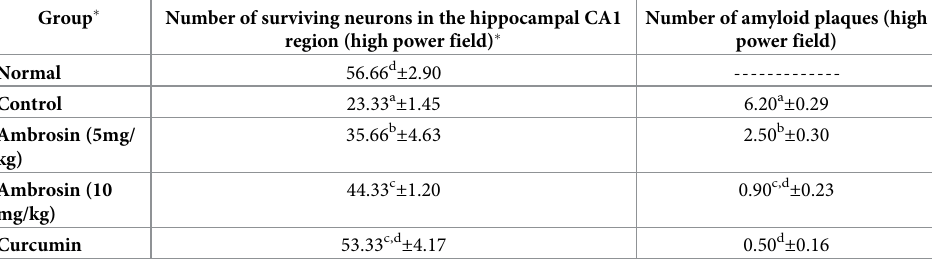
Table 3. Quantification of surviving neurons in the hippocampal CA1 region and quantification of amyloid pla- ques found by histochemical examination of brains of tested groups. Group � Number of surviving neurons in the hippocampal CA1 region (high power field) �